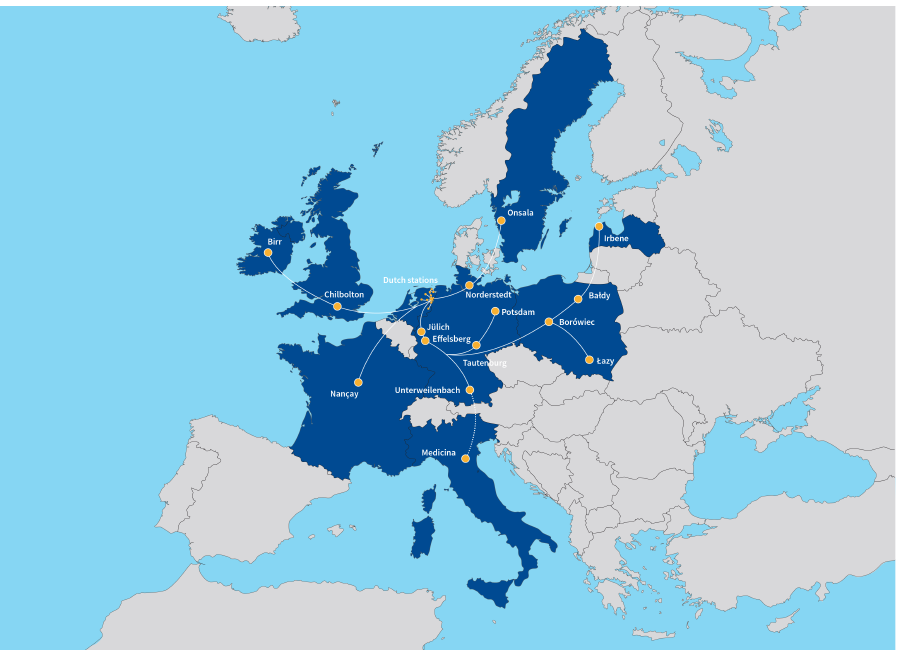
Figure 1. Locations of existing and planned LOw-Frequency ARray (LOFAR) stations in Europe. Credit: Netherlands Institute for Radio Astronomy